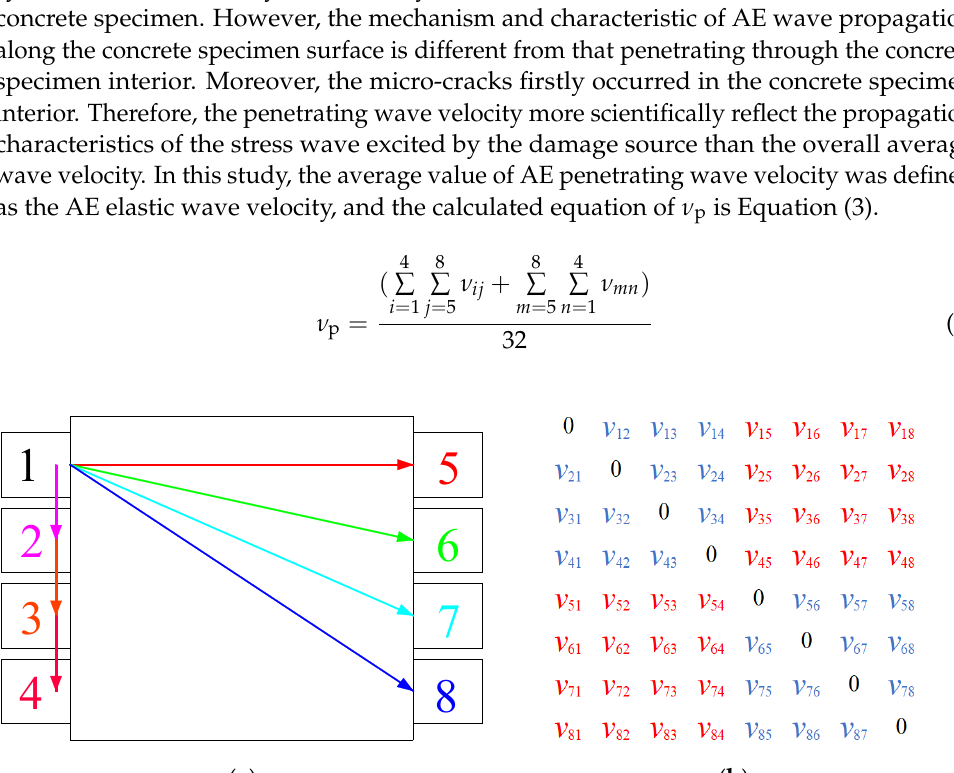
Figure 4. The schematic diagram of AE elastic wave velocity.